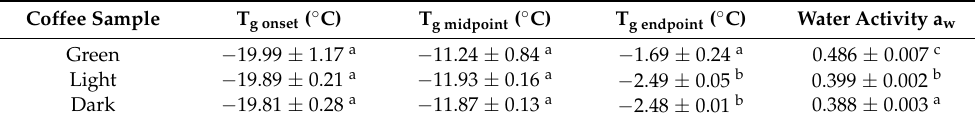
Table 1. Onset, midpoint and endpoint of the glass transition temperature determined in coffee samples ( ± ) standard deviation (SD) from triplicate